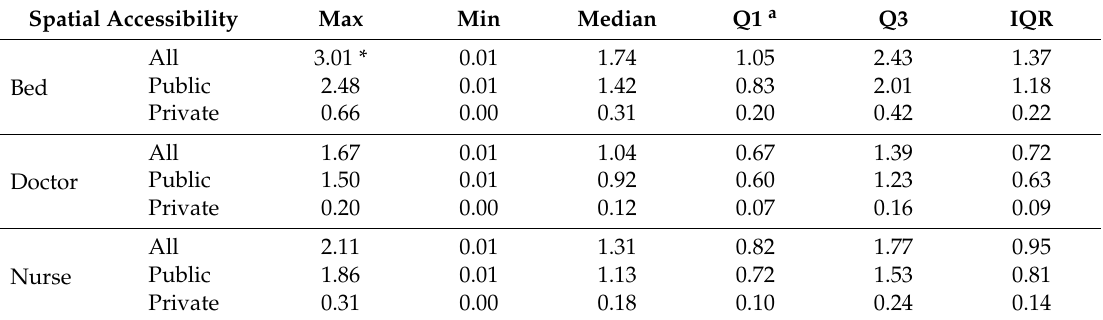
Table 2. Spatial accessibility scores for beds, doctors, and nurses in general